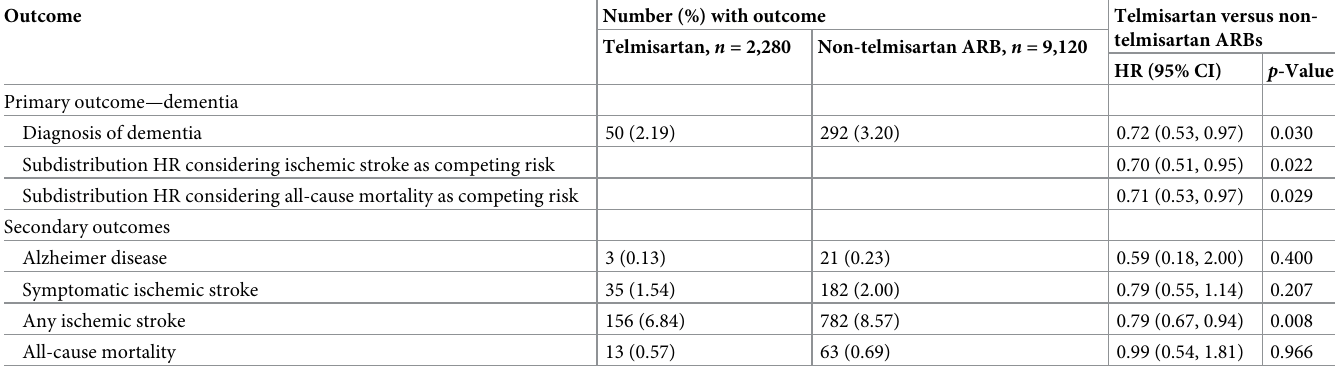
Table 2. Occurrence of primary and secondary outcomes of patients with and without use of telmisartan AU : IeditedthecolumnandrowheadsofTable 2 tomatchPLOSstyle ð particularlythatcolumnheadsmustapplytotheentirecolumn Þ : Iremovedthemid (cid:0) tablecolumnheads ; withallthenecessaryinformation ð includingsomeinformationthatwaspreviouslygiveninfootnotes Þ nowpresentedinthecolumnandrowheads : Pleasecheckthatthestructureiscorrect : . Outcome Number (%) with outcome Telmisartan versus non-